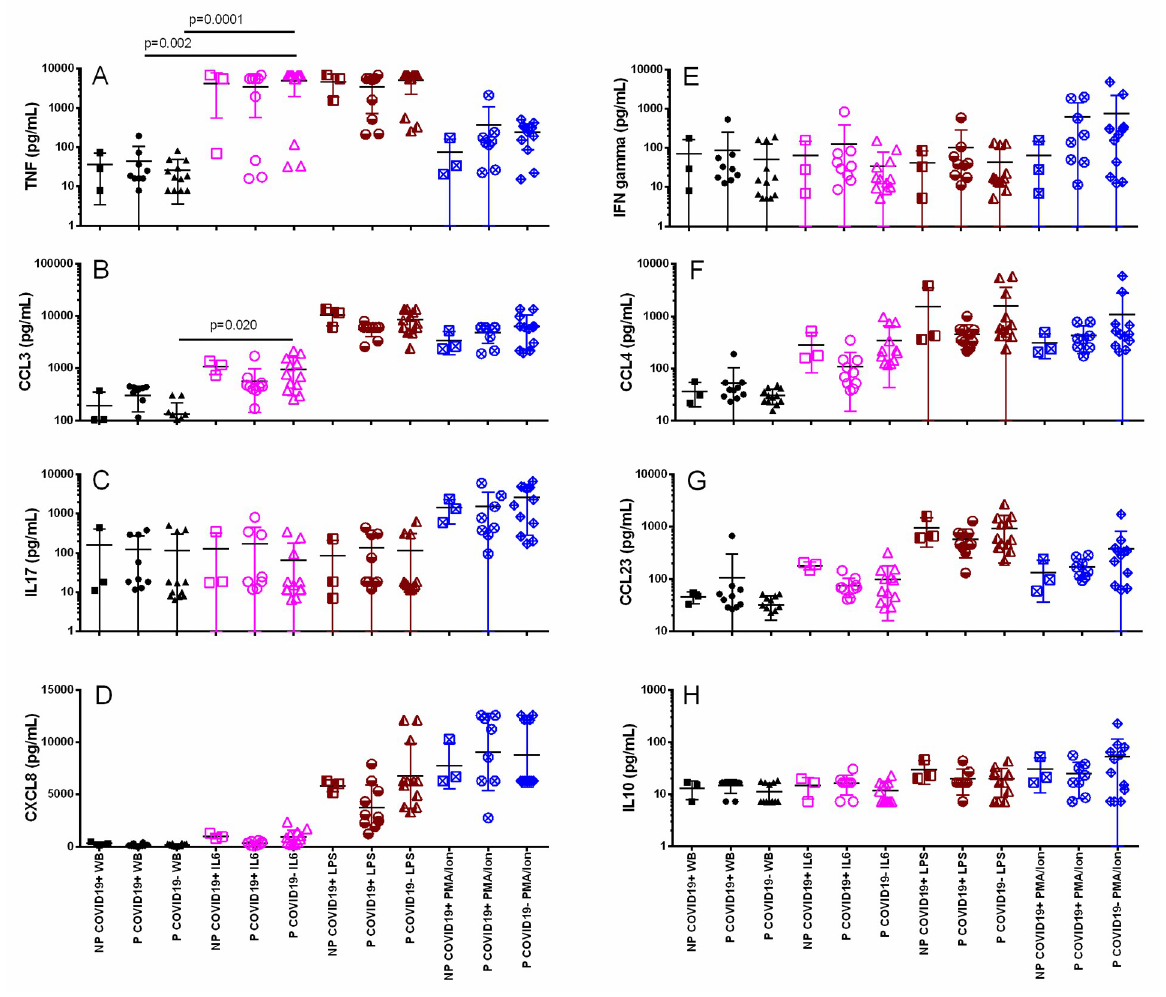
Fig 4. Cytokine/chemokine response after 4 hours of culture with polyclonal stimulus in pregnant and nonpregnant women with or without COVID-19. The supernatant was collected, and cytokine/chemokine concentrations were determined using bead-based immunoassays as described in the methods. The results are expressed as the mean ± SD. Significance value was p < 0.05. Kruskal–Wallis and Dunn’s multiple comparisons tests were calculated. Non-Pregnant COVID-19 positive (NP-COVID-19+, n = 3). Pregnant COVID-19 positive (P-COVID-19+, n = 8–10). Pregnant COVID-19 negative (P-COVID-19-, n = 12). WB, Whole Blood.